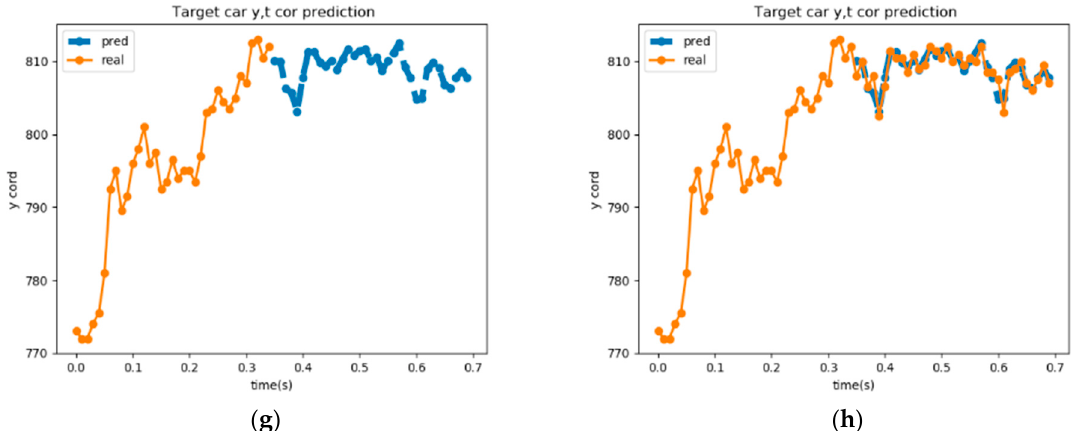
Figure 22. The training of the car trajectory prediction model. We showed the results in four rows: ( a ) the accuracy of predicting x coordinates model, ( b ) the loss of predicting x coordinates model, ( c ) the accuracy of predicting y coordinates model, ( d ) the loss of predicting y coordinates model; ( e ) and ( f ) compare the real x coordinates and predicted x coordi- nates. The blue line is x coordinates predicted by our model, and the orange line is the real x coordinates; ( g ) and ( h ) compare the real y coordinates and predicted y coordinates. The blue line is y coordinates predicted by our model, and the orange line is the real y coordinates. Table 11. The training results of car trajectory prediction model.